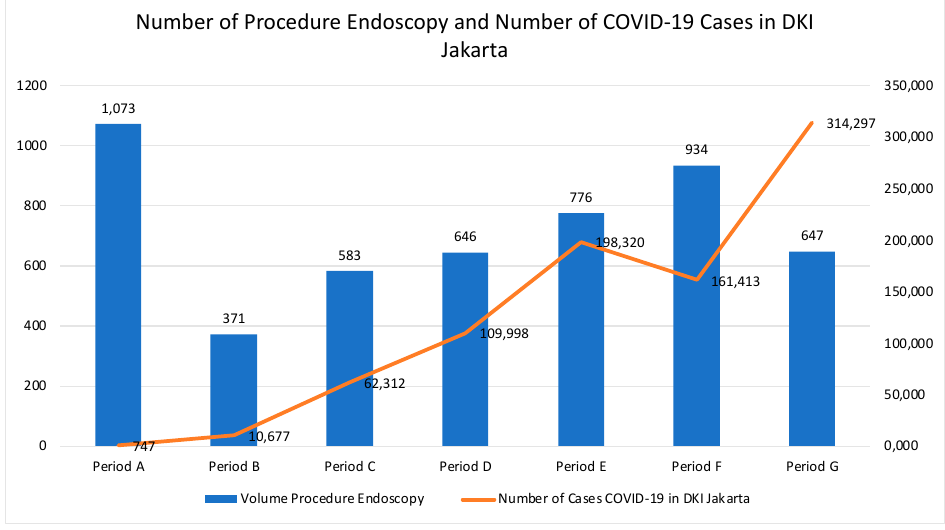
Figure 3. Trends in Endoscopy Service Volume Compared to Daily COVID-19 Cases in Jakarta.